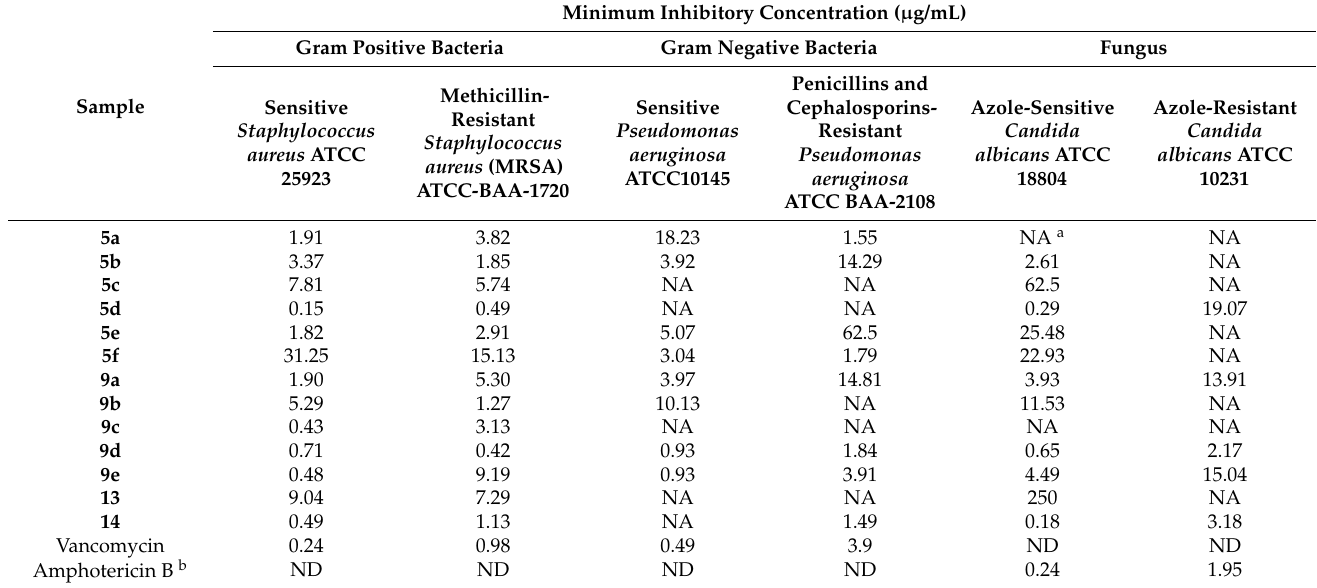
Table 1. MIC of the synthesized compounds against sensitive and resistant microorganisms.